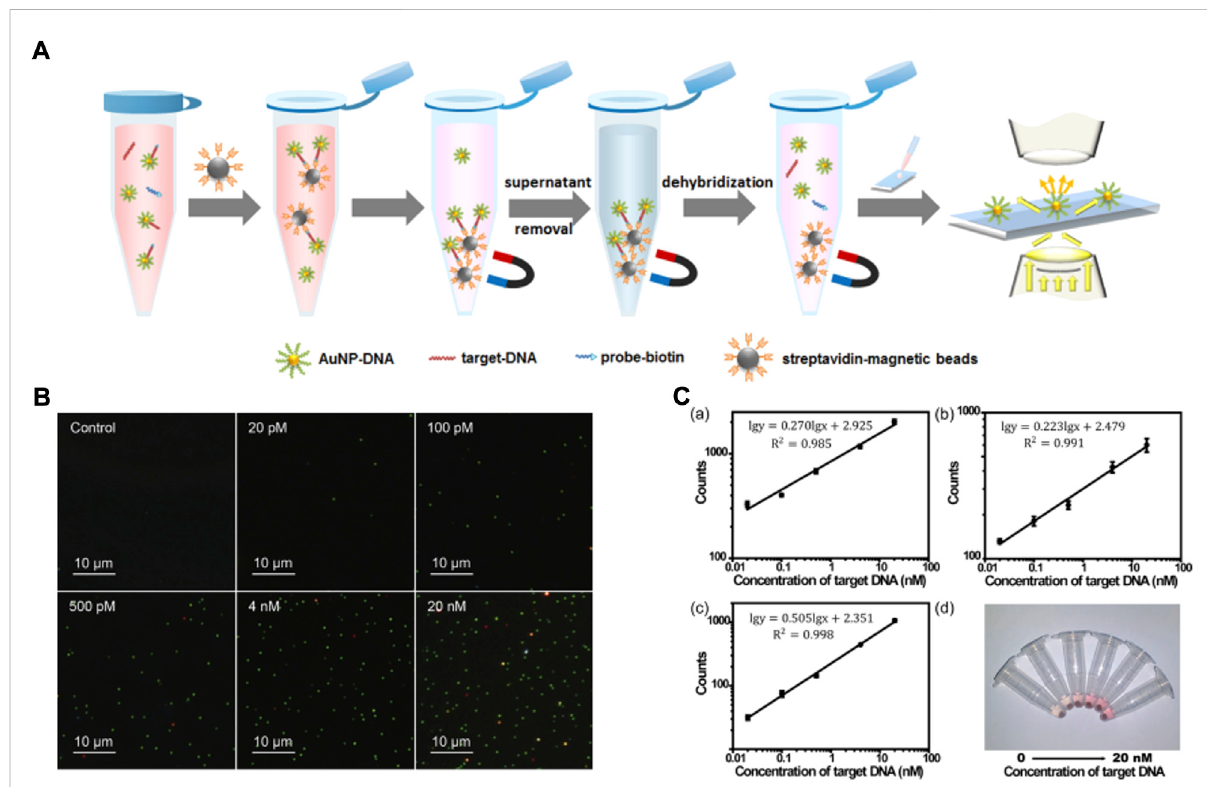
FIGURE 6 (A) The schematic illustration of nucleic acid extraction method combining the sandwich-type DNA hybridization strategy and magnetic separation. (B) Dark- fi eldimagesofAuNP-DNA withdifferentconcentrationsof40-nucleotide targetDNA. (C) Automaticcountingresultsfortarget DNA with different lengths: (a) 24 nucleotides, (b) 40 nucleotides, and (c) 60 nucleotides; (d) the photograph of the supernatant with different concentrationsof40-nucleotidetargetDNA(fromlefttoright,0p.m.,20p.m.,100p.m.,500p.m.,4 nM,and20 nM).Copyright2016American Chemical Society. Copyright 2021 Elsevier